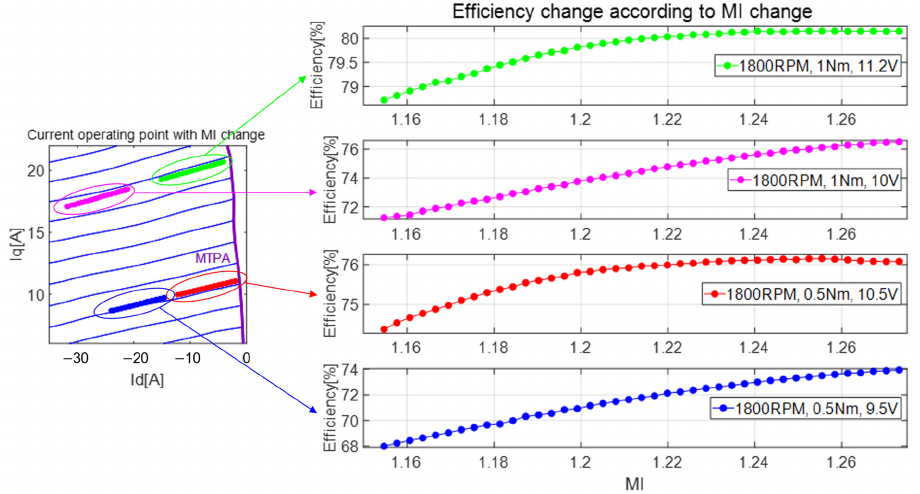
Figure 14. Experimental results of efficiency change according to MI change.